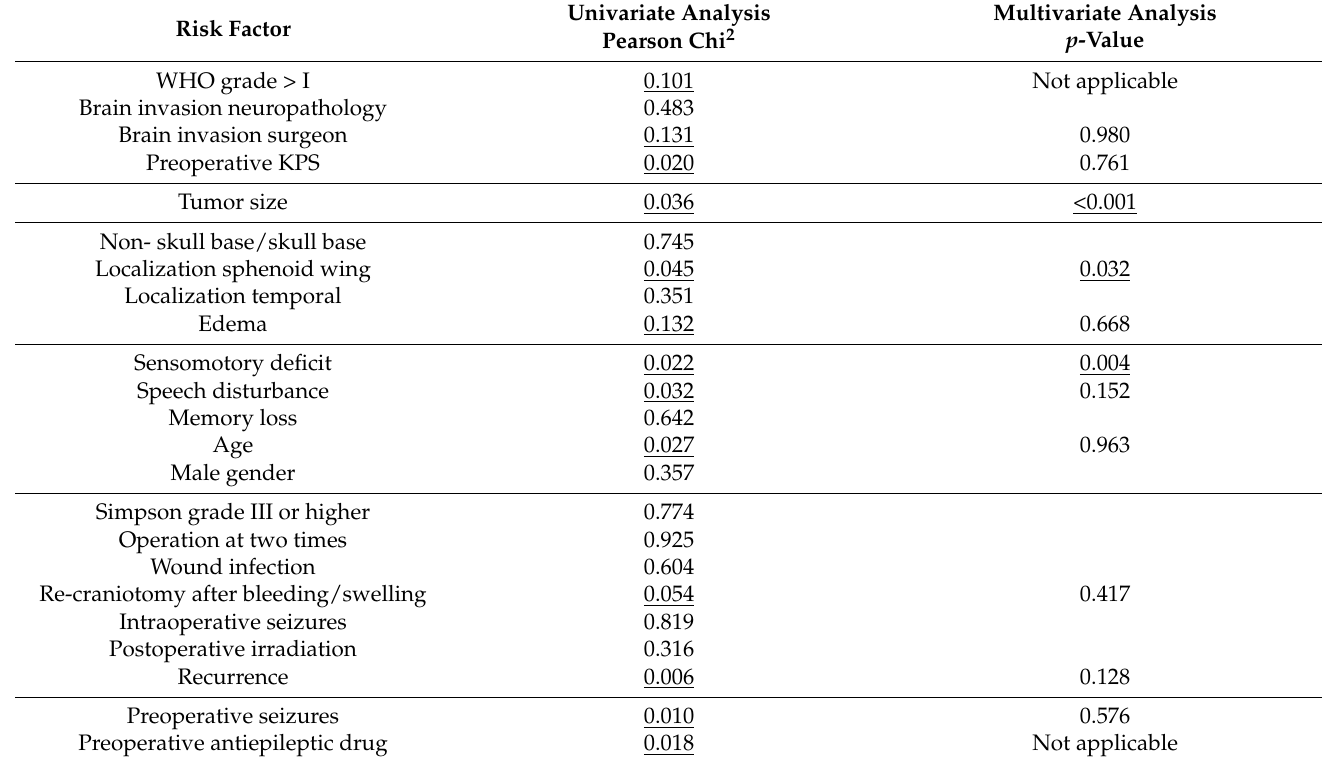
Table 4. Risk factors for postoperative